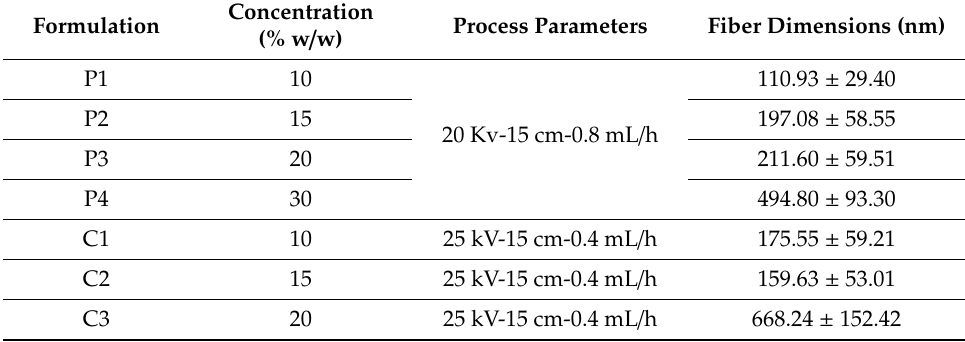
Table 2. Mean fiber dimensions of PCL (P1-P4) and collagen (C1-C3) electrospun formulations.